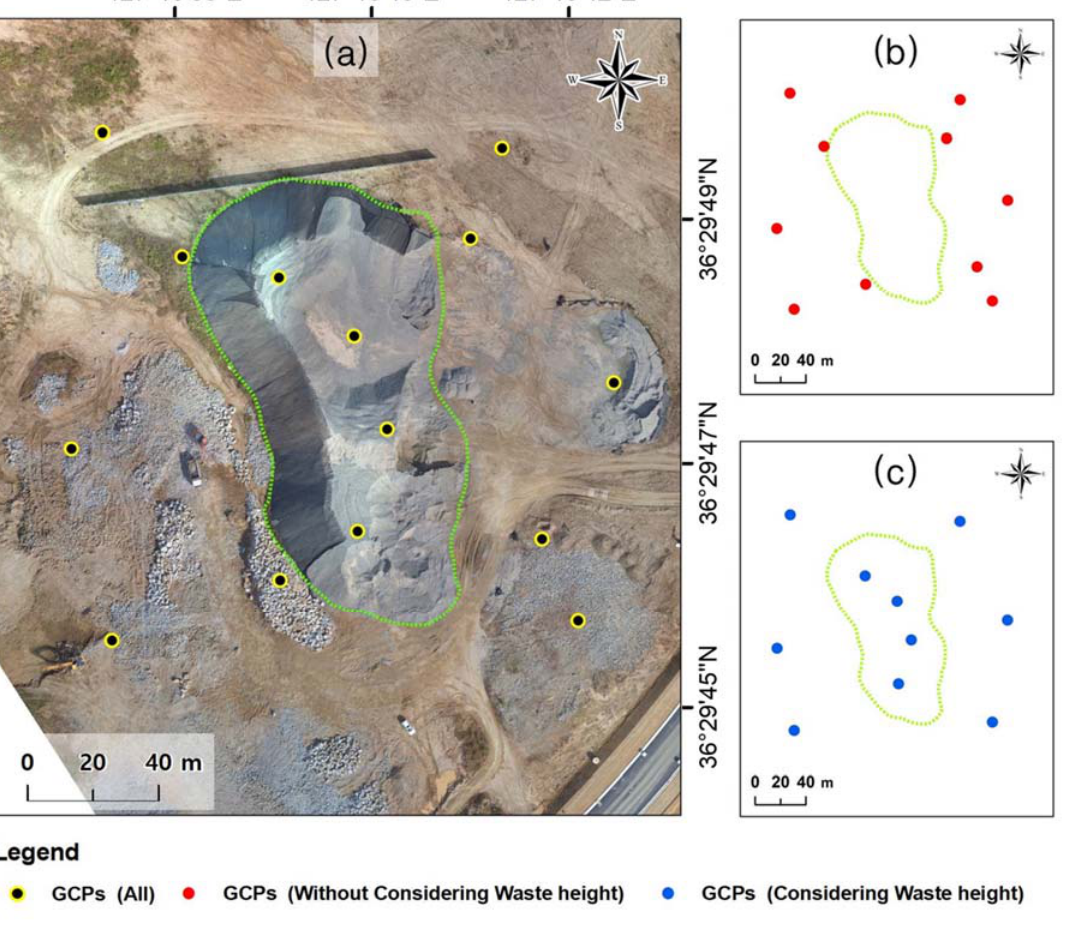
Figure 3. Ground control point (GCP) positions: ( a ) all GCPs, ( b ) GCPs placed without considering waste height, and ( c ) GCPs placed considering waste height.